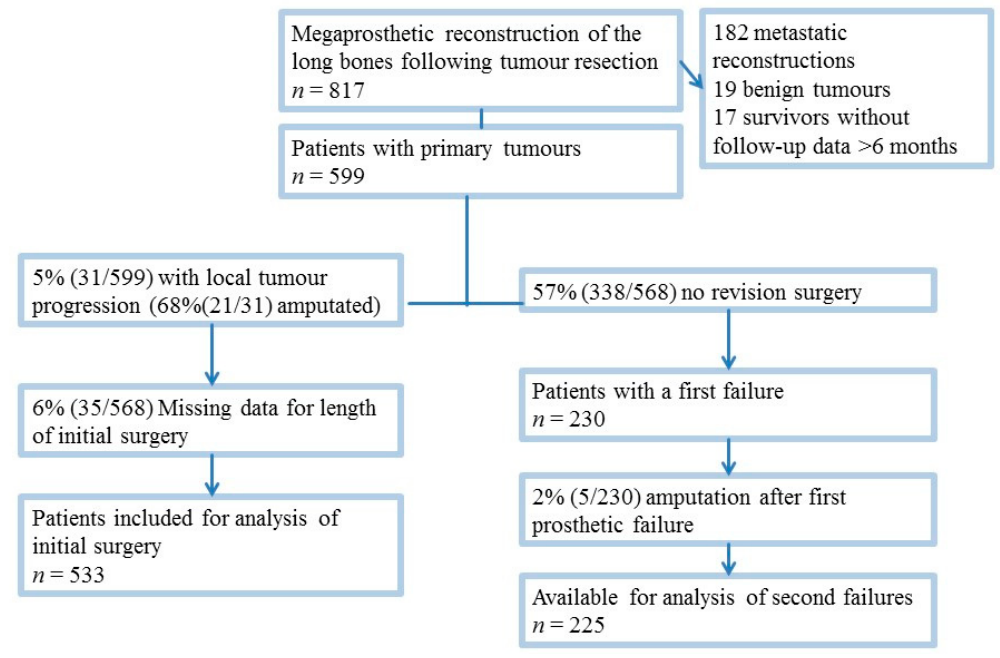
Figure 1. STROBE diagram showing inclusion of